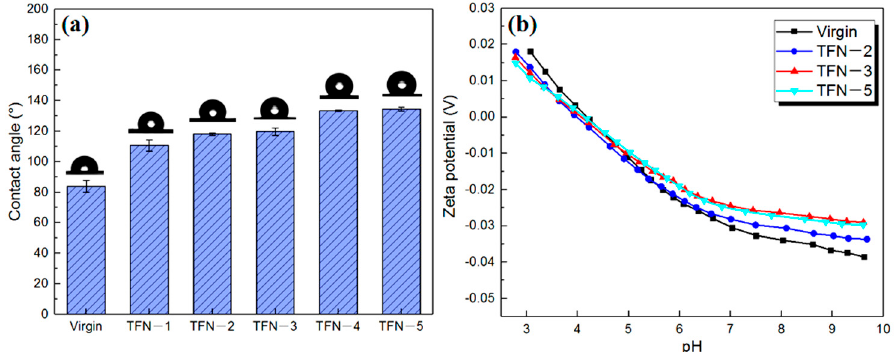
Figure 8. Contact angle results ( a ) and zeta potential analysis ( b ) of RO membranes.